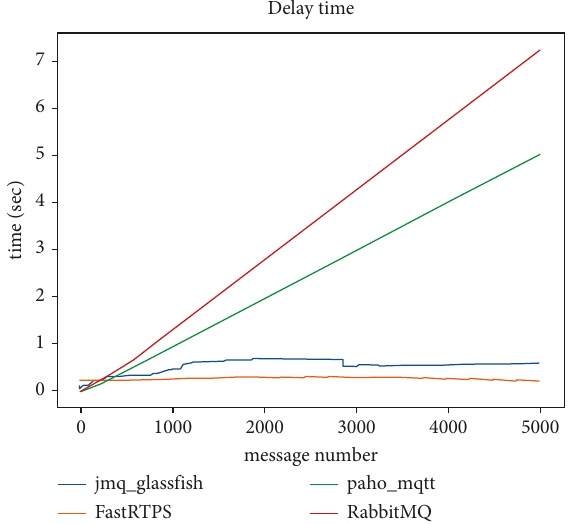
Figure 3: Delay of messages with the size of 50 bytes.